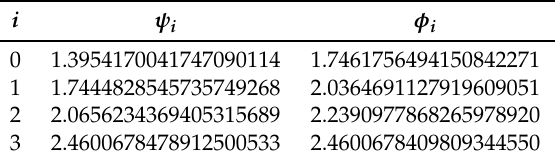
Table 1. Values in radians of ψ i and φ i for Example